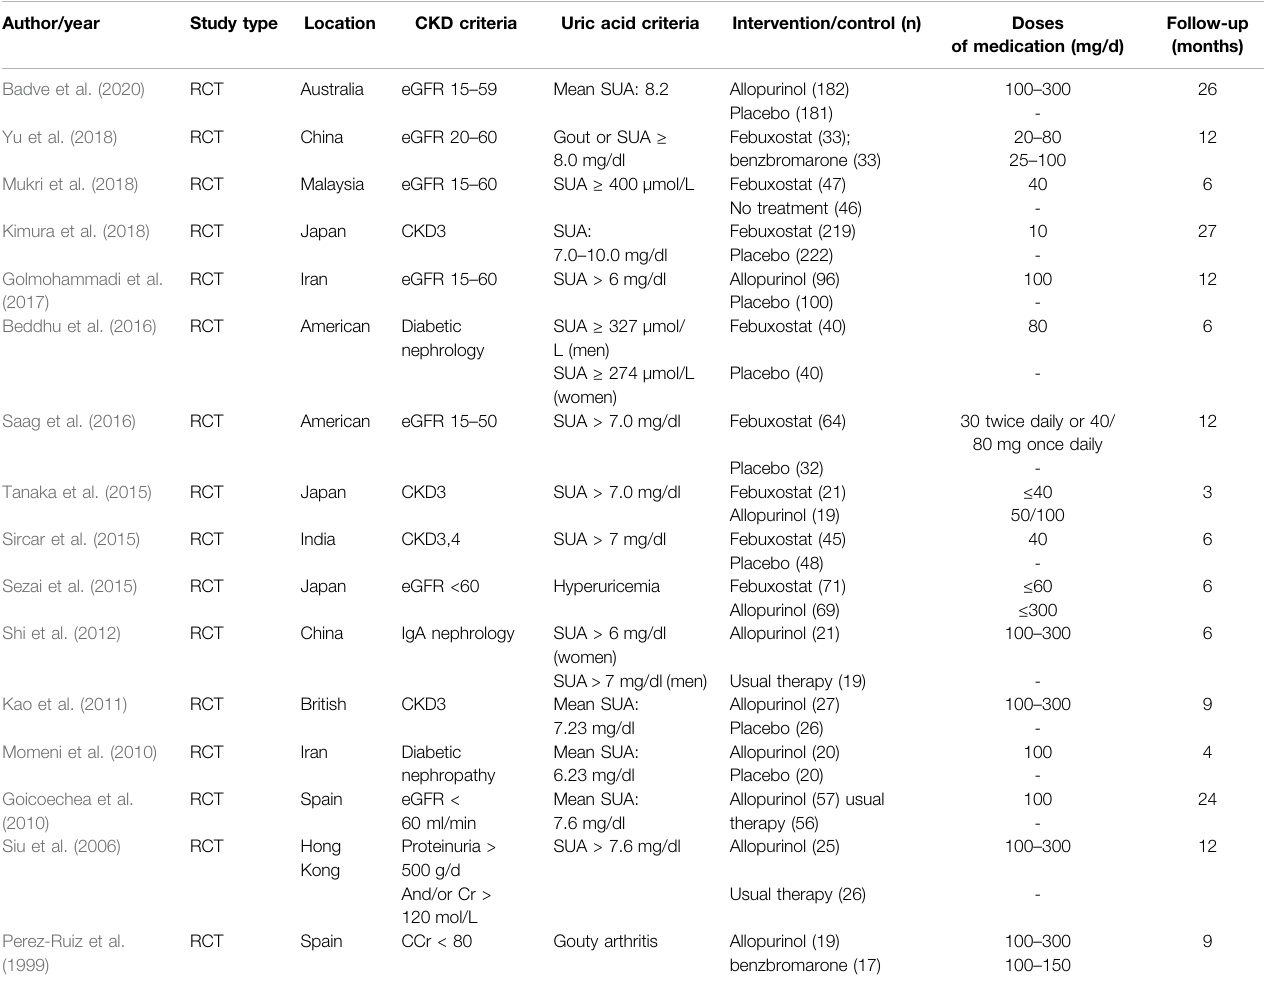
TABLE 1 | Study characteristics of included